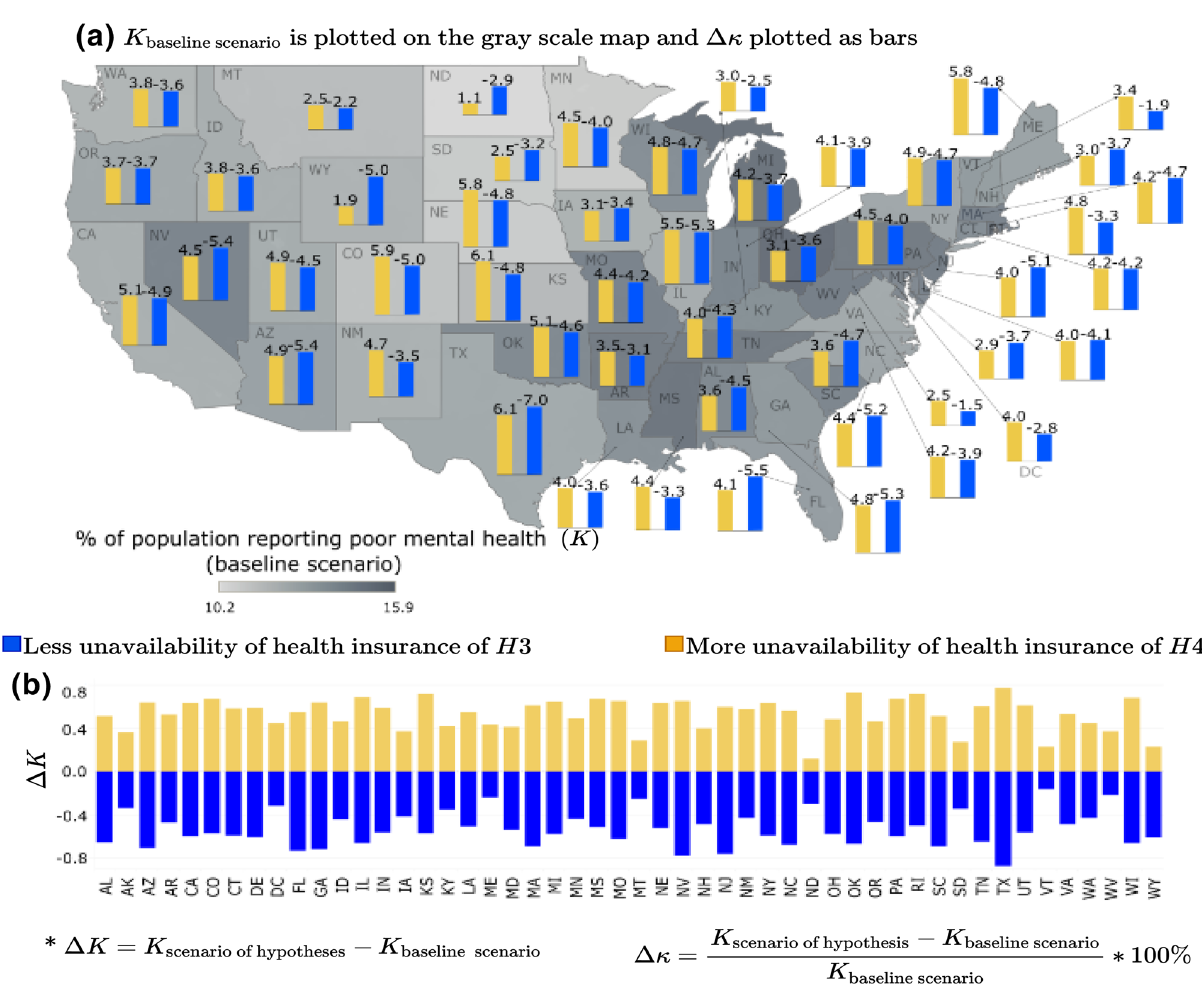
Figure 4. Unavailability of health insurance scenario for % of adults aged > 18 years reporting poor mental health for > 14 days ( K ): ( a ) �κ is plotted as the bars and K for base line scenario is plotted as gray scale intensity on the US map; and for ( b ) (cid:31) K is plotted. The maps are created using Tableau 2021.2 (Tableau 2021.2 New Features) and Adobe Illustrator (Software and services for creative business teams | Adobe Creative Cloud for